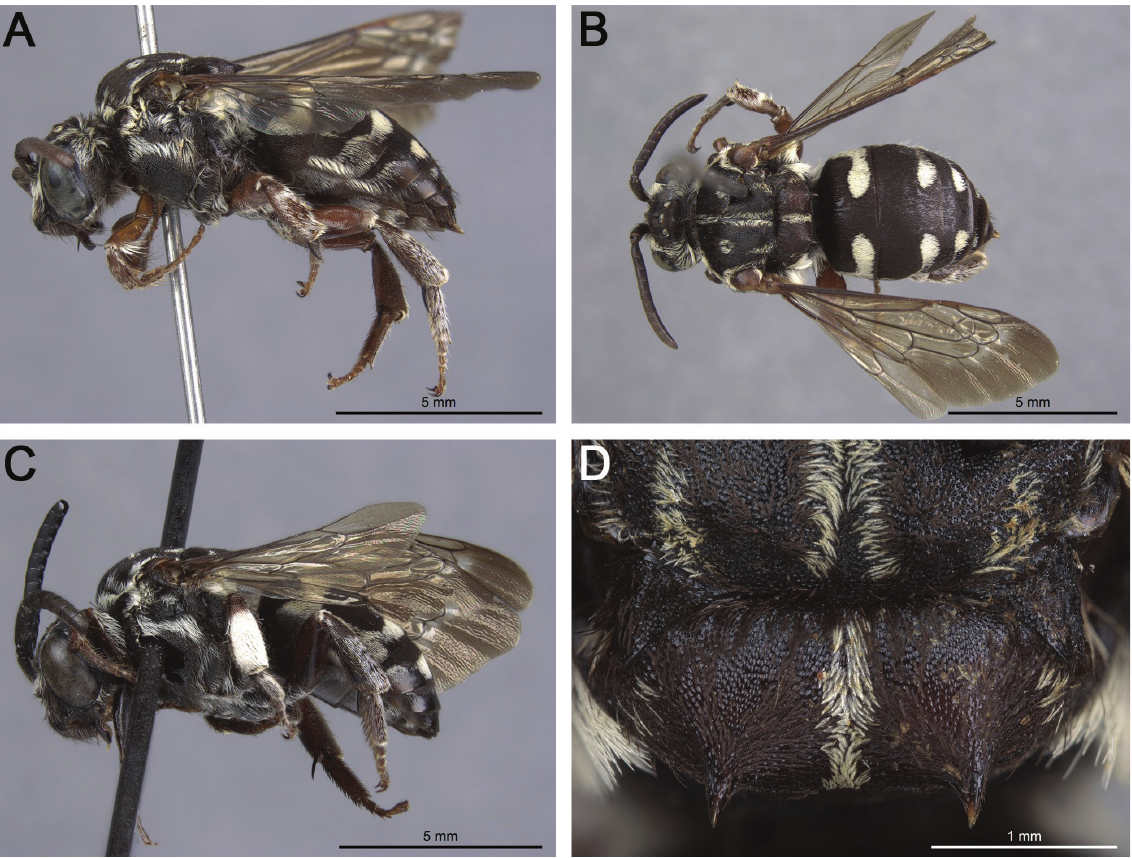
Fig. 16. Brachymelecta tibialis (Fabricius, 1793). A–B, D. Female (INHS 427051). A . Habitus, lateral view. B . Habitus, dorsal view. C . Male (UPRM), habitus, lateral view. D . Axillae and mesoscutellum, dorsal